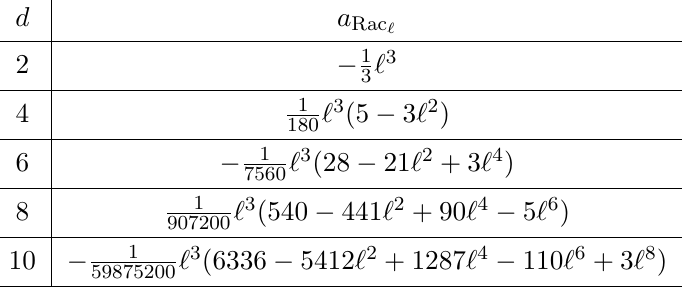
Table 1 . Summary of a -anomaly coefficients for the order- ℓ real scalar in low